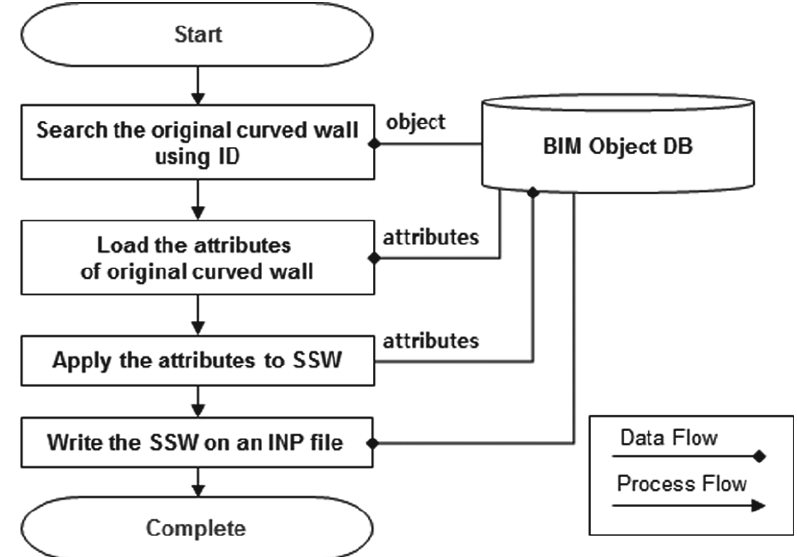
Fig. 10. Process of generating INP file